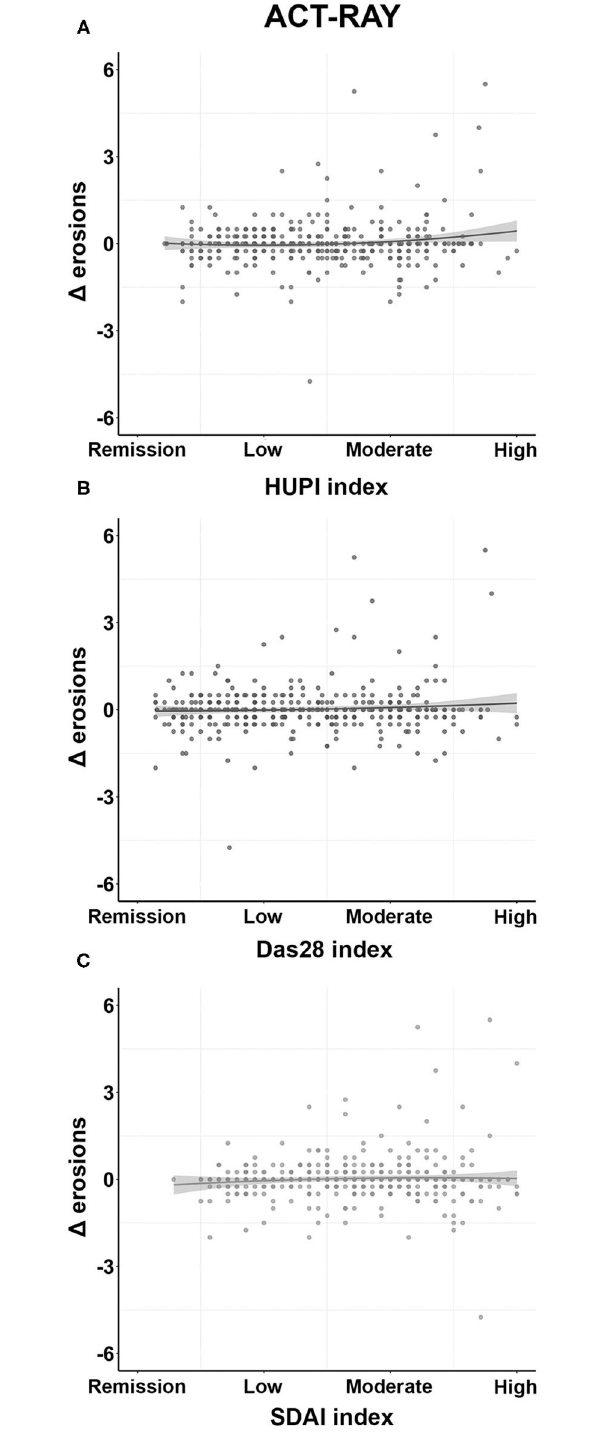
FIGURE 3 | Distribution of 1 erosions according to the different disease activity indices in the ACT-RAY study. (A) , (B), and (C) : Distributions according to HUPI, DAS28, and SDAI categories, respectively. Disease activity values represent patients’ mean disease activity through follow-up. Data are shown as dot-plots and their fitted linear prediction (line) with 95% confidence intervals (grey